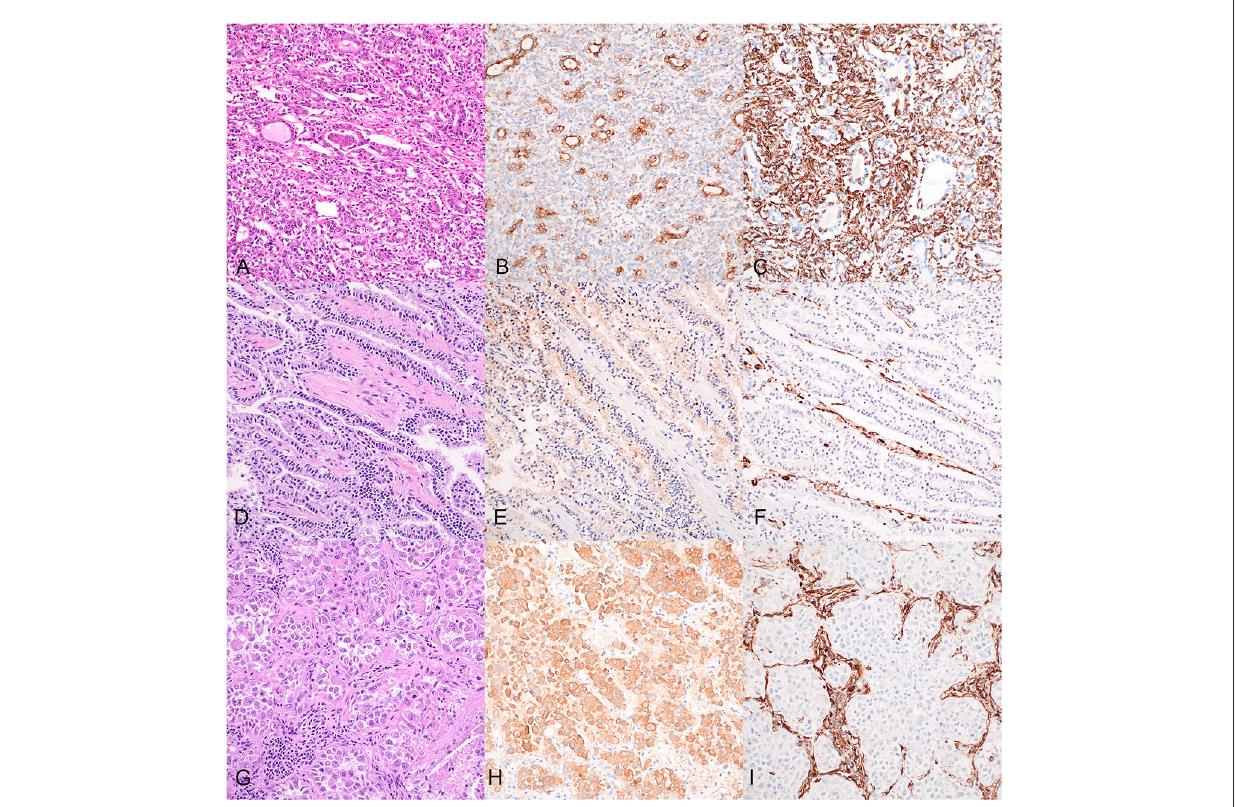
FIGURE3 Histopathology and immunostaining of the dog’s renal cell carcinoma (A–C) , accessory lung lobe neoplasm (D–F) , and right caudal lung lobe neoplasm (G–I) . 20X. (A) Renal cell carcinoma in which neoplastic epithelial cells are arranged in tubules, nests, and streams; hematoxylin and eosin (HE). (B) Cytokeratin immunohistochemistry (IHC) of the renal cell carcinoma: positive cytoplasmic staining of neoplastic epithelial cells. (C) Vimentin IHC of the renal cell carcinoma: positive cytoplasmic staining of neoplastic epithelial cells. (D) Accessory lung lobe neoplasm in which neoplastic cells are arranged in lepidic cords and papillary projections; HE. (E) Cytokeratin IHC of the accessory lung lobe neoplasm: moderate positive cytoplasmic labeling of neoplastic cells. (F) Vimentin IHC of the accessory lung lobe neoplasm: negative staining of the neoplastic cells. (G) Right caudal lung lobe neoplasm in which neoplastic cells are arranged in nests amongst abundant inflammation and necrosis; HE. (H) Cytokeratin IHC of the right caudal lung lobe neoplasm: strong positive cytoplasmic labeling of the neoplastic cells. (I) Vimentin IHC of the right caudal lung lobe neoplasm: negative staining of the neoplastic